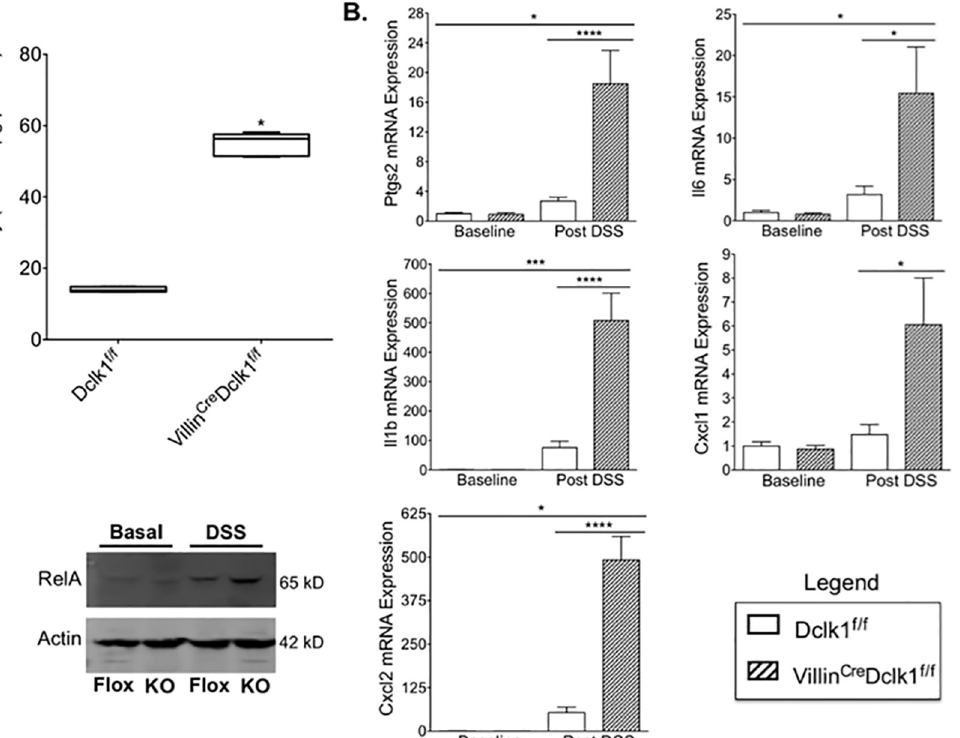
Fig 4. Deletion of epithelial Dclk1 exacerbates DSS-induced inflammation of the colonic mucosa. A. Colonic MPO activity was dramatically increased in the Villin Cre ;Dclk1 f/f mice following DSS treatment; B . The mRNA expression levels of Ptgs2, Il6, Il1 β , Cxcl1, and Cxcl2 in colonic tissues were measured by quantitative real-time RT-PCR, and normalized against β -actin. Values in the bar graphs are given as mean ± SEM, * p < 0.02, **** p < 0.0001 Villin Cre ; Dclk1 f/f vs Dclk1 f/f ; C . The protein expression level of RelA in colonic tissues was analyzed by Western blotting.